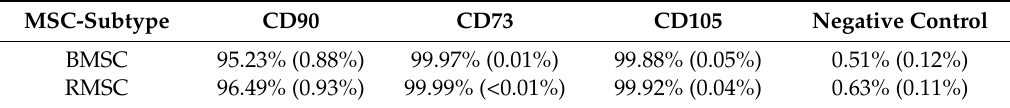
Table 1. Results of flow cytometry analysis.